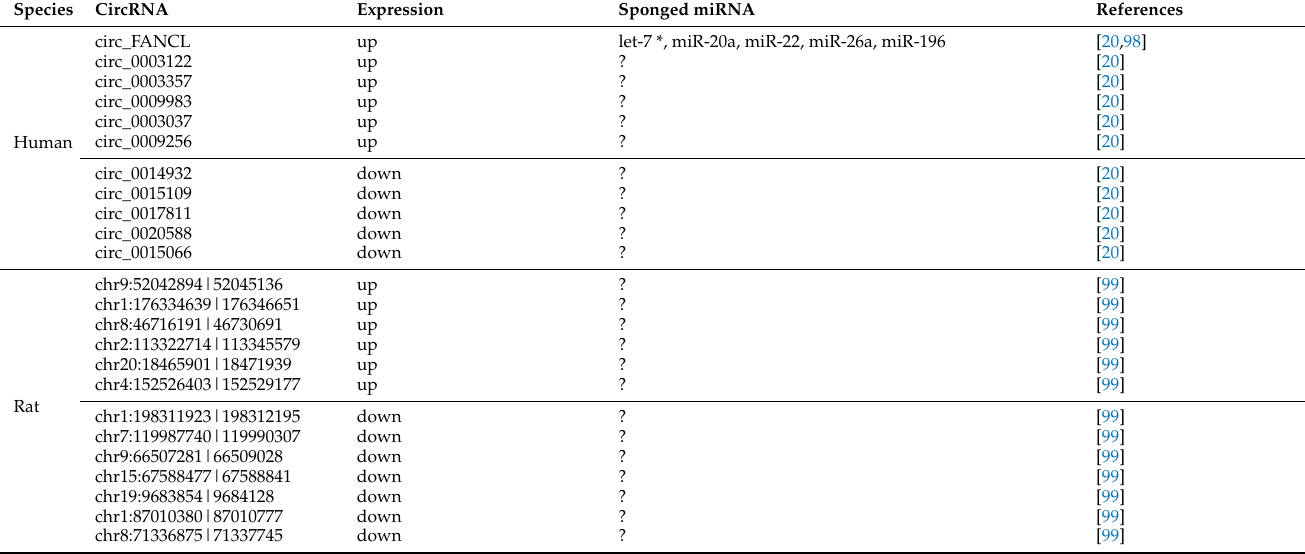
Table 2. Dysregulated circRNAs in